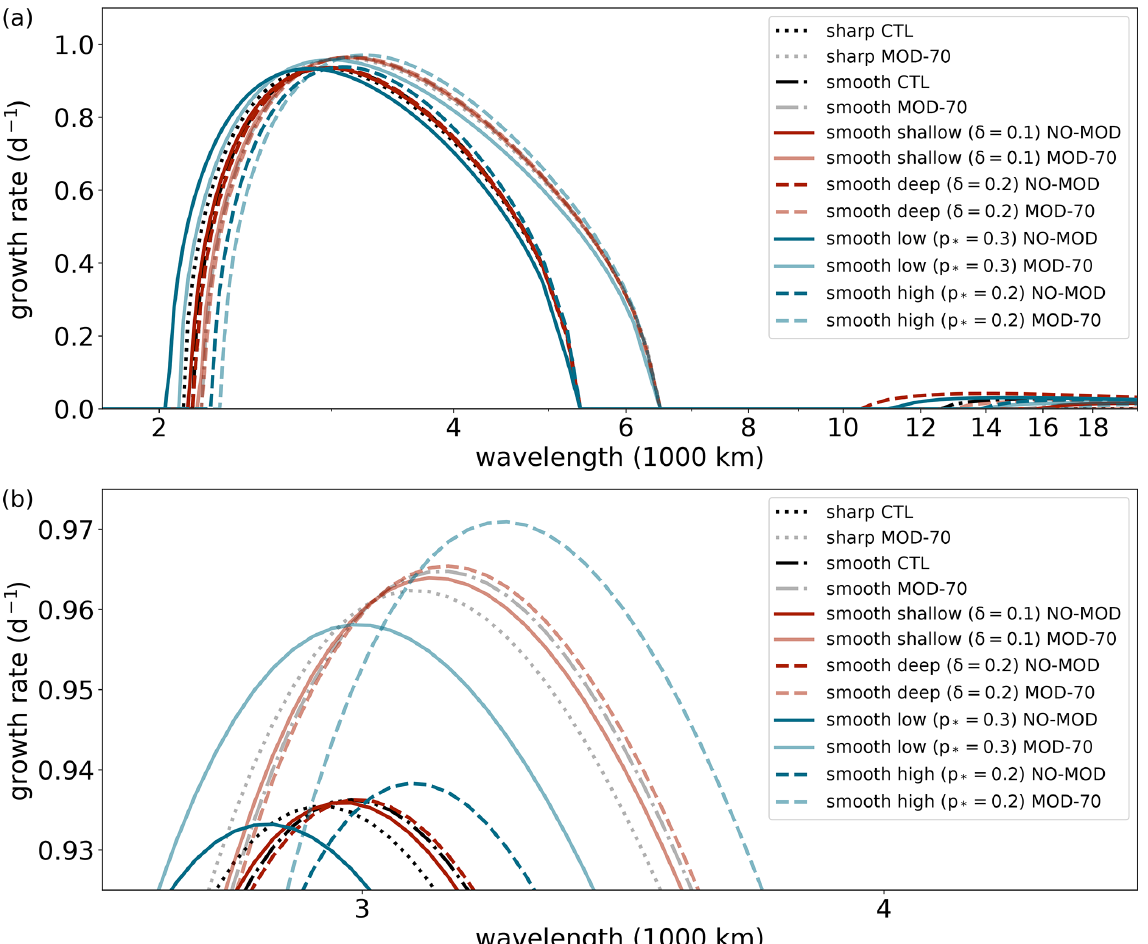
Figure 6. (a) Growth rate vs. wavelength for λ tr = 3 . 5, λ st = − 3 . 5, S tr = 1, S st = 4, and various sensitivity experiments, with the default smooth experiment being associated with a tropopause region of 150hPa depth centred at an altitude of 250hPa. See text for further details. (b) Magnification of panel (a)